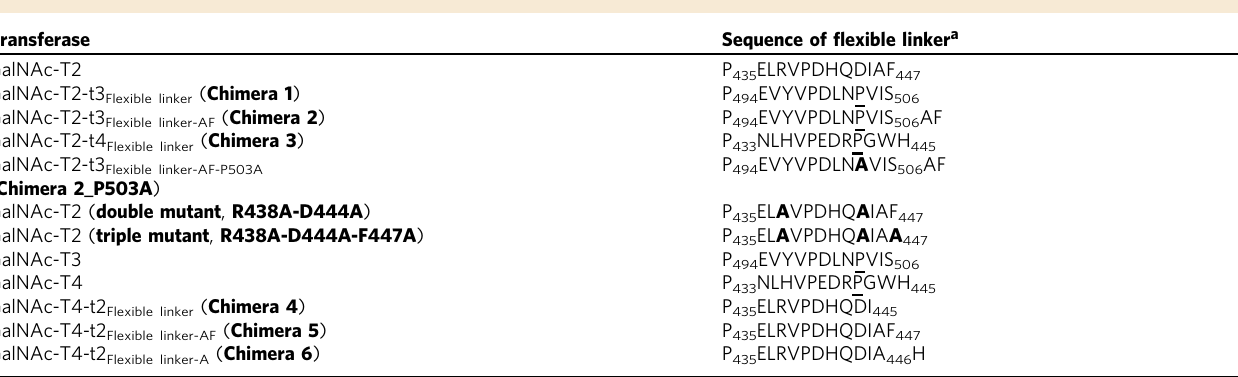
Table 2 Sequences of the chimeras and mutant GalNAc-Ts used in this study